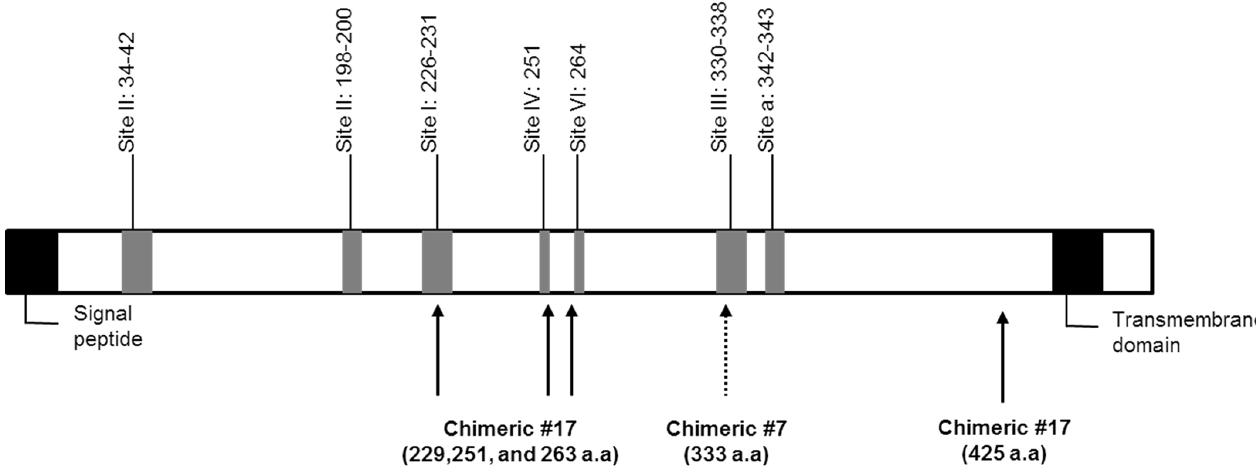
Fig 3. Antigenic site on RABV G protein. A schematic illustration is shown of the antigenic sites of chimeric MAbs #7 and #17. The amino acid numbersare based on the mature G protein minus the signal peptide.The signal peptideand transmembrane domainregion are also indicated.